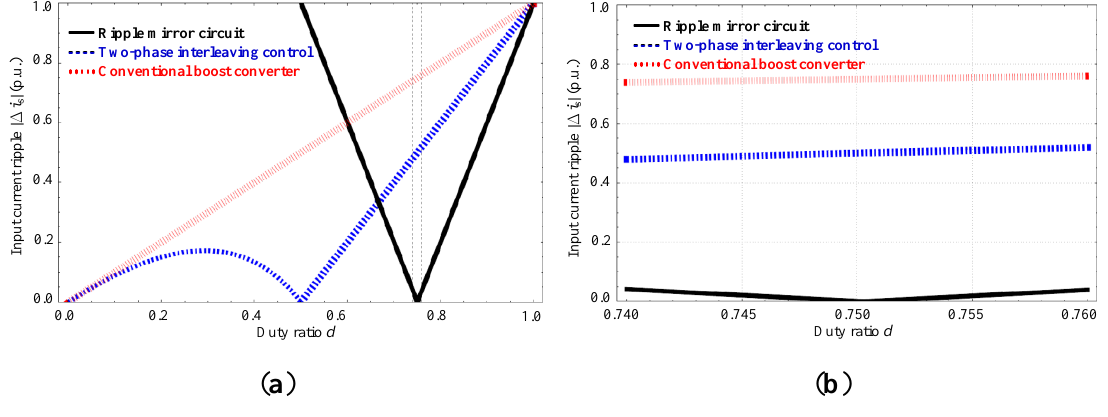
Figure 7. The absolute value of the input current ripple, | Δi s |, versus the duty ratio d with different techniques. ( a ) With full range of duty ratio d and ( b ) around the duty ratio d =